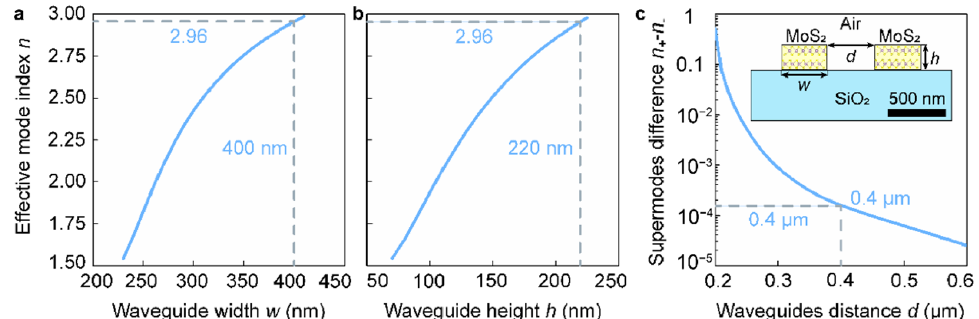
Figure A1. Dependence of the effective index of the fundamental mode for one waveguide ( a ) on its width and ( b ) on its height. ( c ) Dependence of the difference between the effective indices of symmetric and antisymmetric modes on the distance between the waveguides.